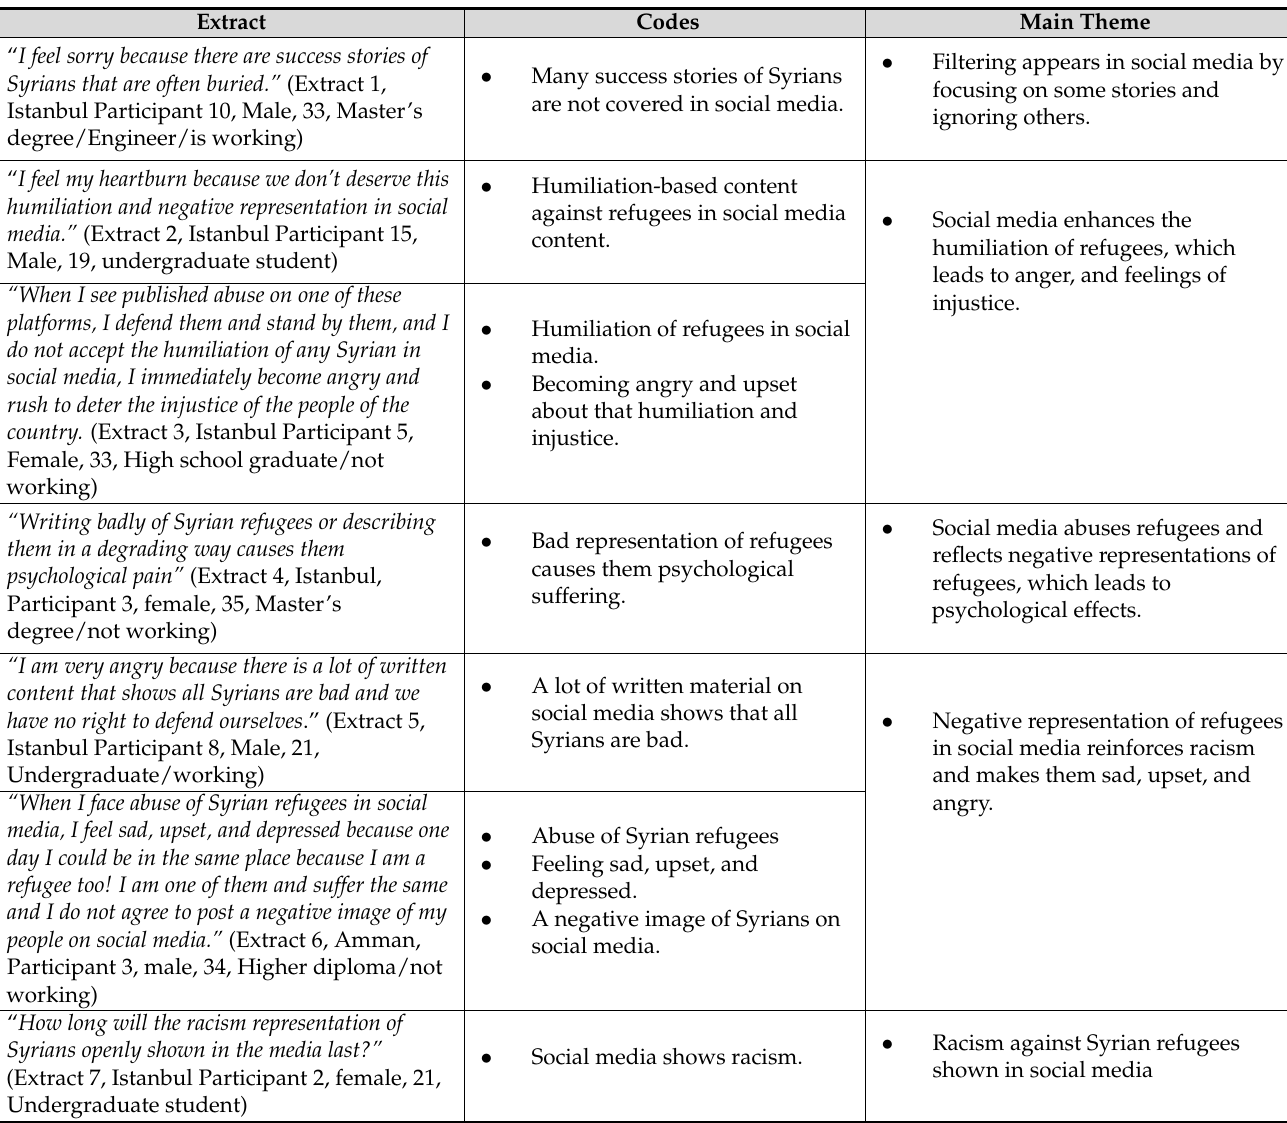
Table 7. Main Extracted Insights from the Participants in the FGDs and their Main